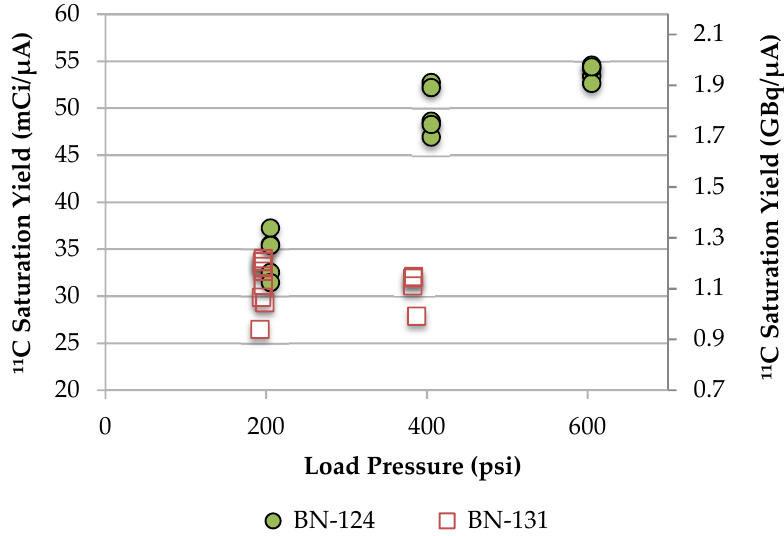
Figure 14. 11 C saturation yield for the BN-124 and BN-131 targets at 5 µ A using nitrogen with 1% oxygen.